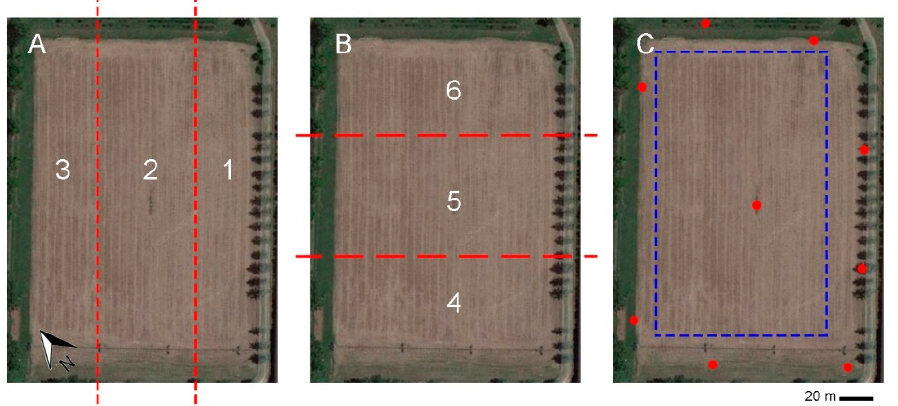
Table 1. Experimental setup: Weather conditions over the three days and daytimes of the flights over the six zones (Figure 1A,B).